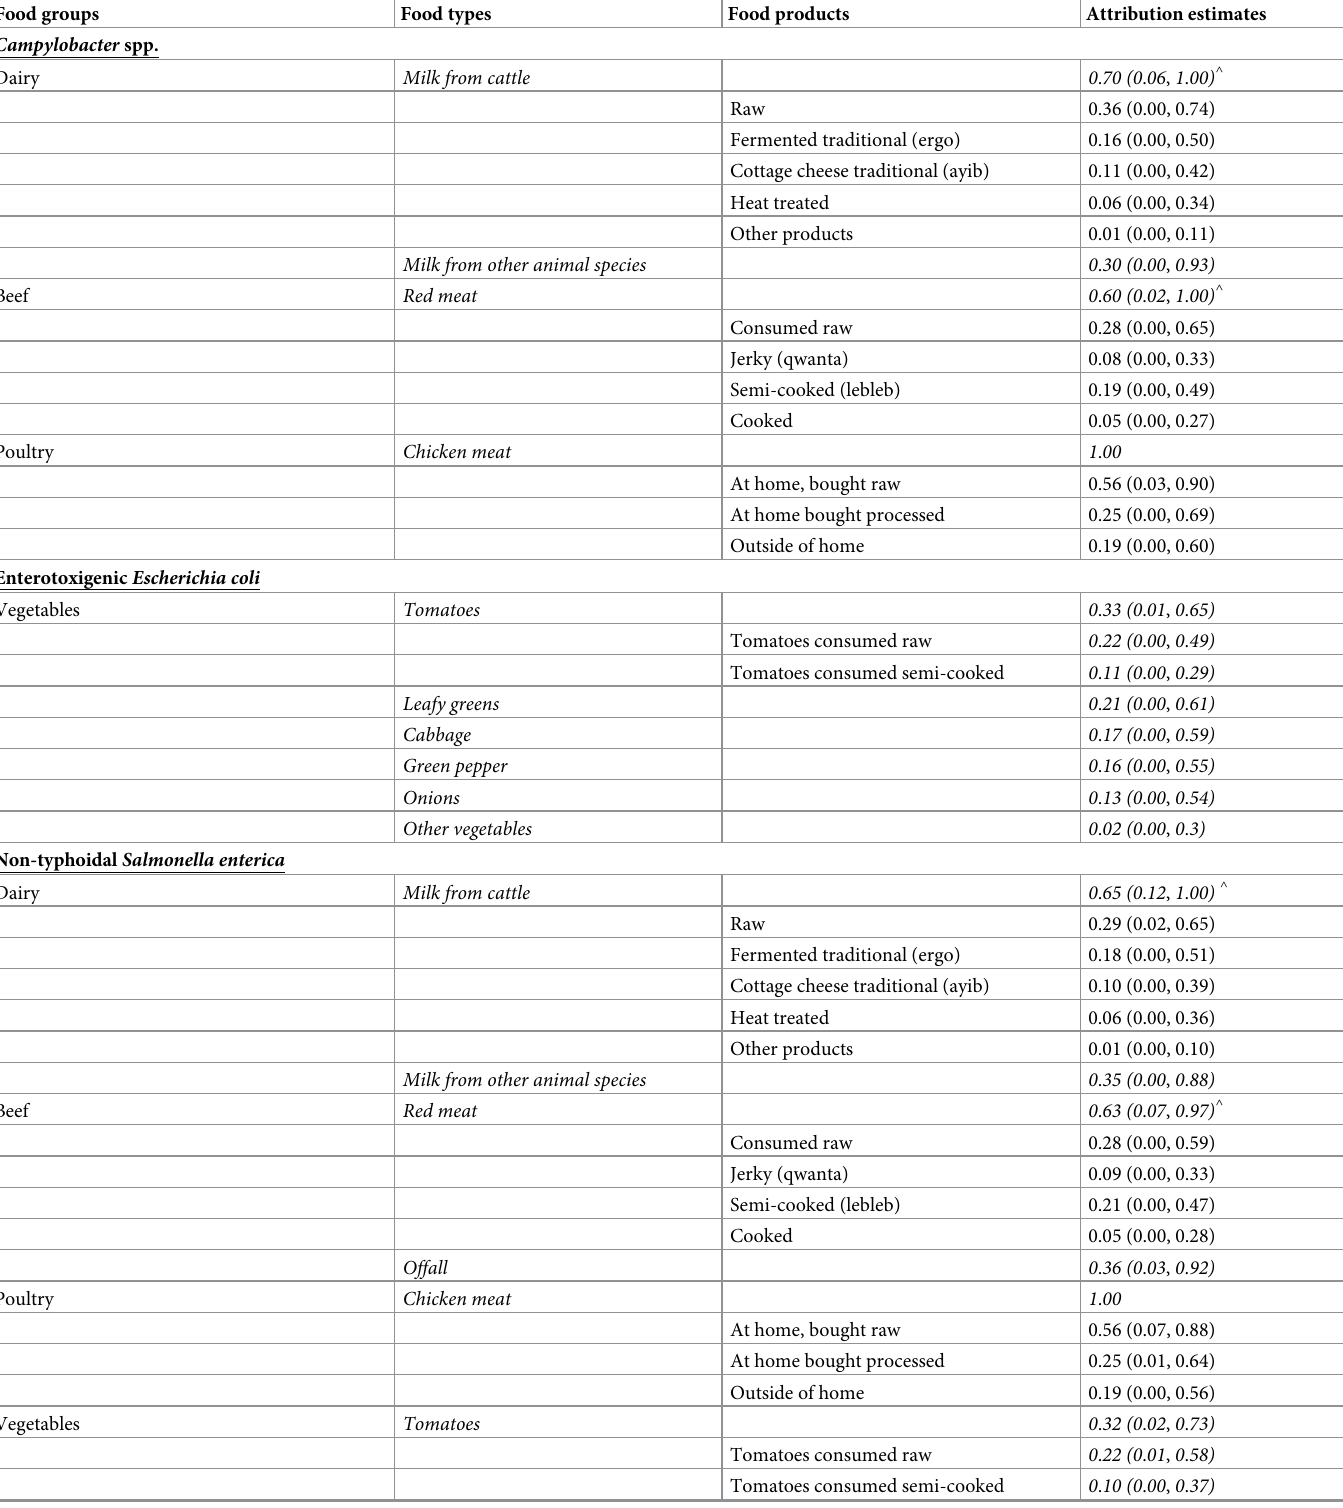
Table 5. Attribution of foodborne disease due to four selected hazards in Ethiopia to food types and food products. Food